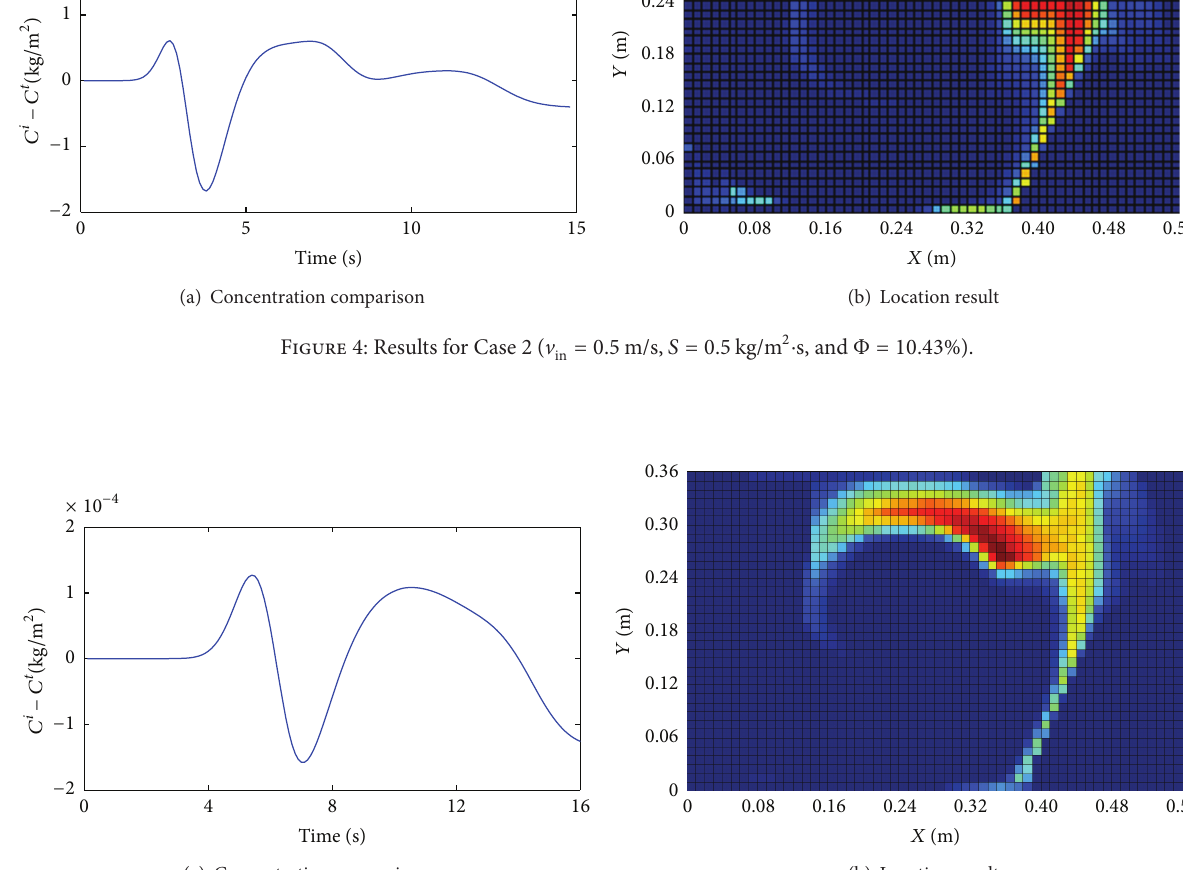
Figure 5: Results for Case 3 ( V